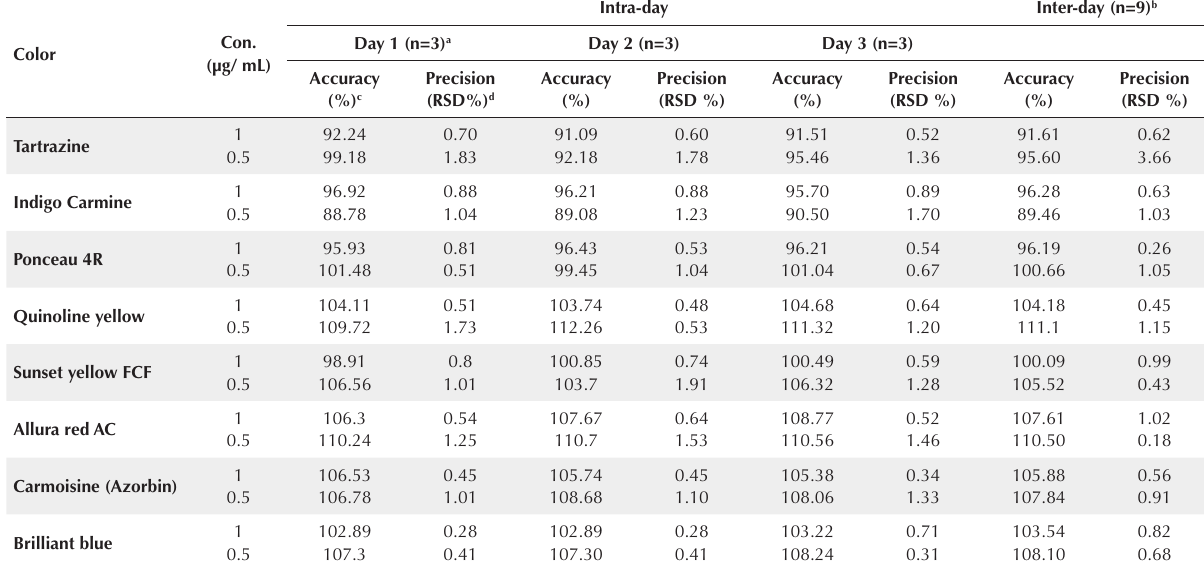
Table 4. Intra and Inter-day Accuracy and Precision Studied for the Proposed IP-HPLC-DAD Method at 1 and 0.5 µg/mL